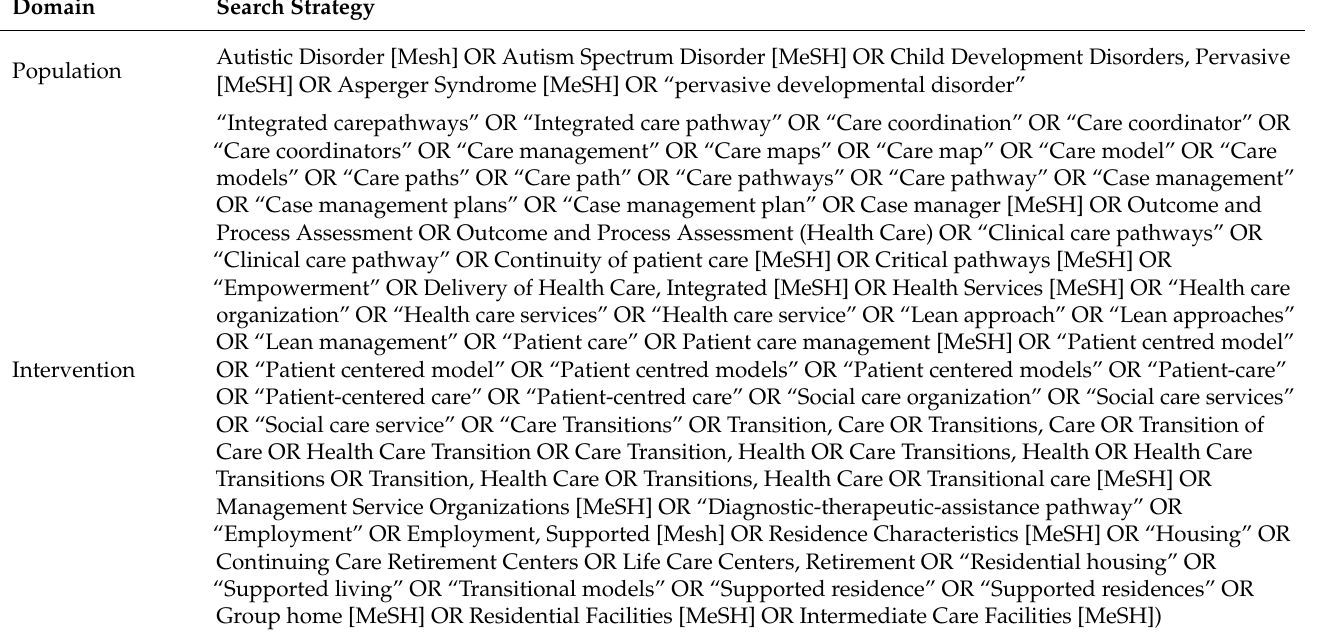
Table 1. The search domains for the database